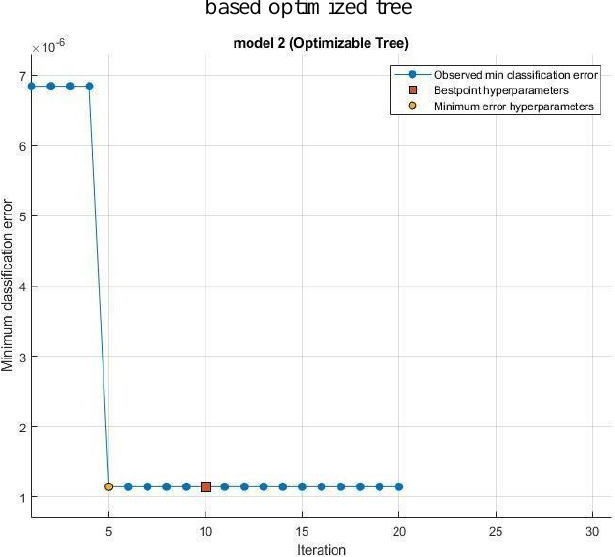
Fig. 7. Active wiretap minimum classification error of grid search based optimized tree